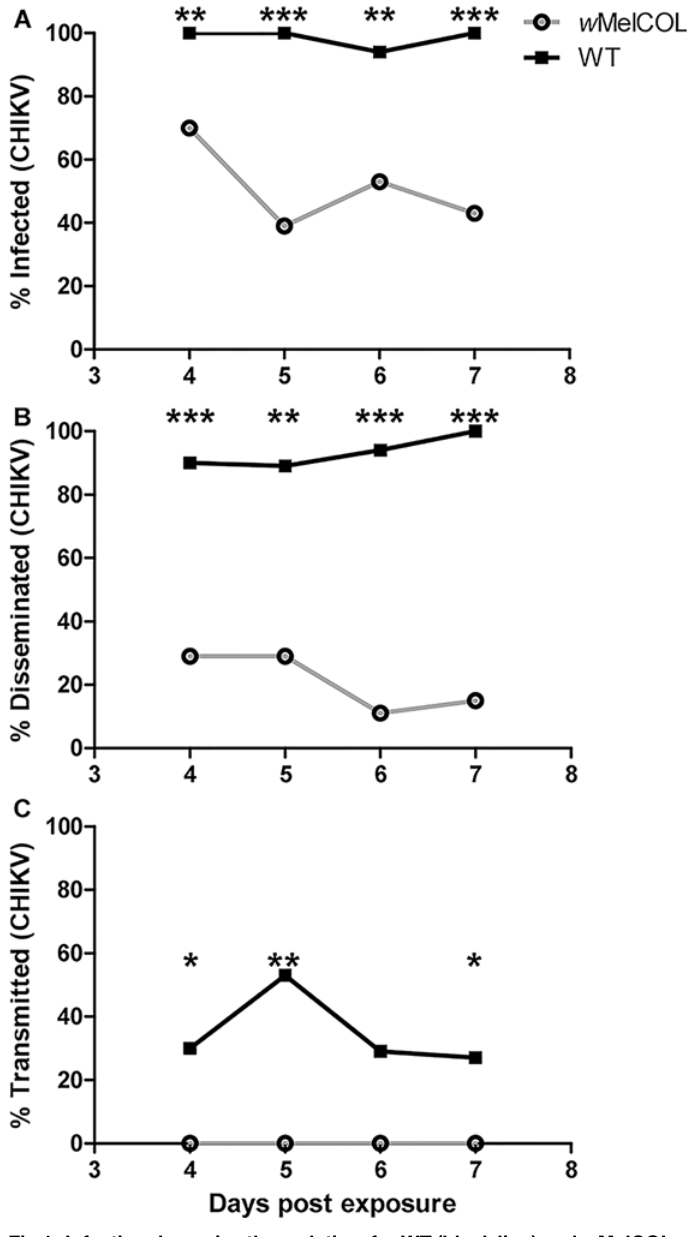
Fig 1. Infection dynamics through time for WT (black line) and w MelCOL mosquitoes (gray line) orally infected with 6.90 log 10 PFU/ml of CHIKV. Mosquitoes were examined at days 4 – 7 to determine infection, dissemination, and transmission efficiencies. Infection efficiency corresponds to the proportion of mosquitoes with virus-infected bodies among the tested ones. Dissemination efficiency corresponds to the proportion of mosquitoes with virus-infected legs, and transmission efficiency corresponds to the proportion of mosquitoes with infectious saliva among those infected. * , significant reduction in infection rates ( * p < 0.05, ** p < 0.01, *** p < 0.001). A). Percent infected (4d, n = 20 for w MelCOL and WT; 5d, n = 18 for w MelCOl and n = 19 for WT; 6d, n = 17 for w MelCOL and n = 18 for WT; 7d n = 30 for w MelCOL and WT. B). Percent disseminated (of infected). C.) Percent transmitting (of